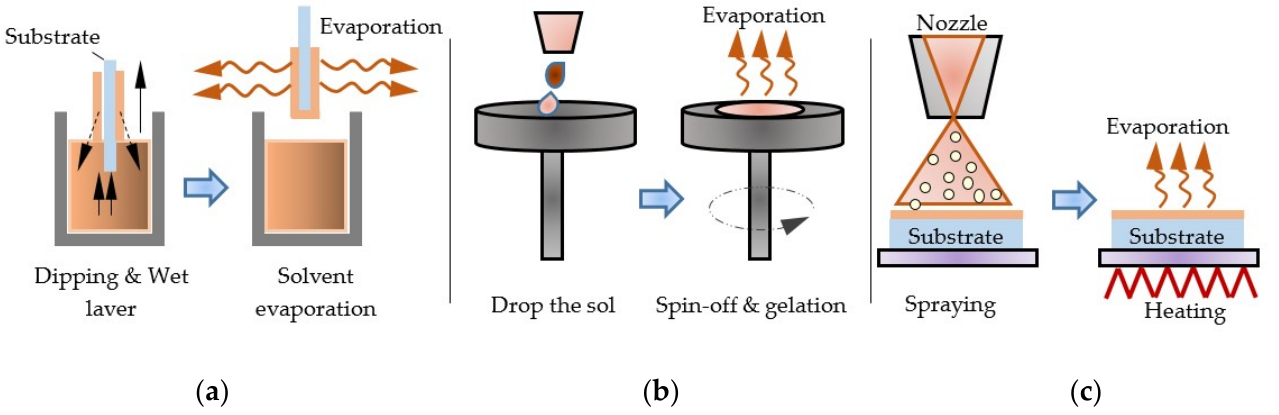
Figure 28. Types of sol–gel processes: ( a ) immersion coating; ( b ) centrifugation; ( c )